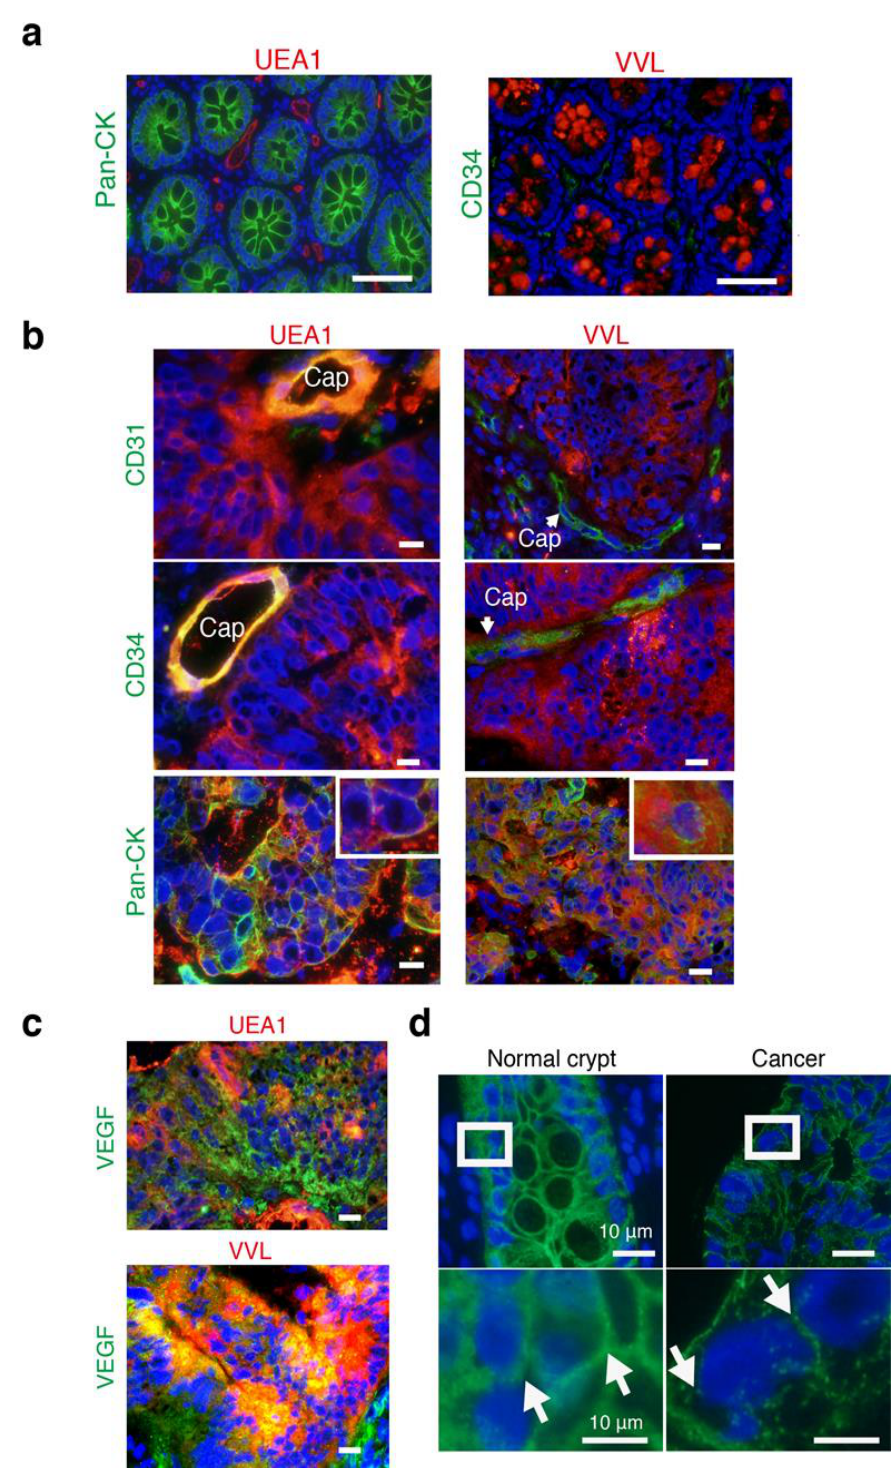
Figure 5. Cancer- and endothelial-related lectins expressed in cancer intercellular regions. ( a ) Merged images illustrating IF staining of lectins (UEA-1 and VVL: Red) and antibodies (pan-CK or CD34: green) with DAPI (blue). Scale bars: 10 μm. ( b ) Merged images illustrating IF staining of lectins (UEA-1 and VVL: red) and antibodies (CD31, CD34, and pan-CK: green) with DAPI (blue). Insets in the Pan-CK panel indicate high magnification. Cap: capillaries. Scale bars: 10 μm. ( c ) Merged images illustrating IF staining of lectins (UEA-1 and VVL: red) and antibodies (VEGF: green) with DAPI (blue). Scale bars: 10 μm. ( d ) Merged images illustrating immunofluorescent (IF) staining of CDH1 antibody (green) with DAPI (blue). Insets in upper images indicate lower high magnification images. Scale bars: 10 μm.